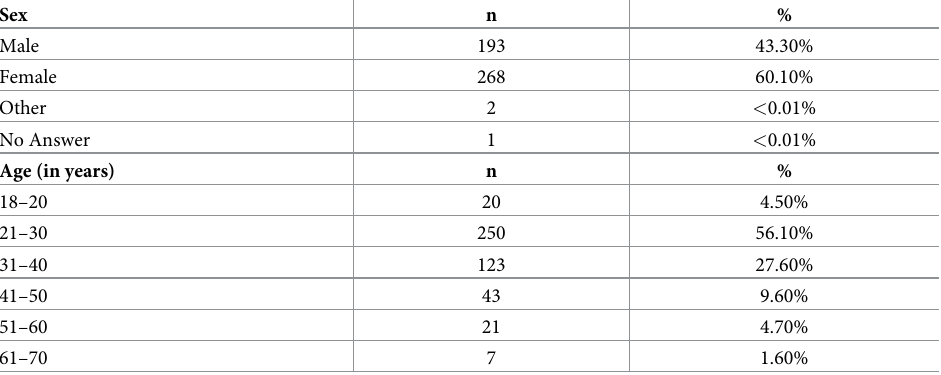
Table 13. Demographic data (n = 464) (Study